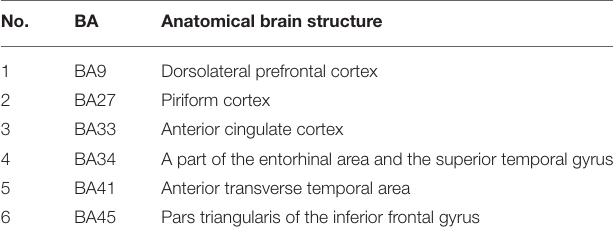
TABLE 3 | The names of the anatomical brain structures of the most active BA mentioned in text.